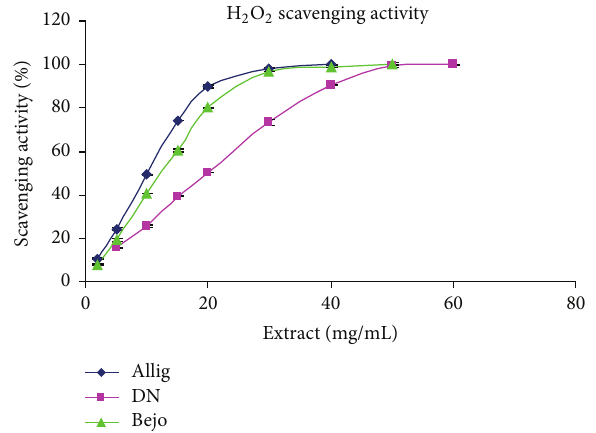
Figure 2: Effect of different concentrations on H 2 O 2 scavenging activity in different date extracts: Allig, Bejo, and Deglet Nour (DN). Values are means of three replications ±